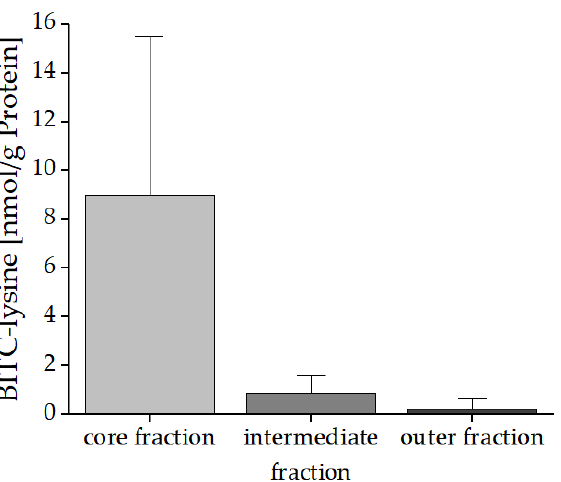
Figure 9. Amounts of the BITC-Lys conjugates in the core, intermediate, and outer fraction of the bread with freeze-dried nasturtium added selectively (application No. III). Three different breads were prepared and analyzed in triplicate.